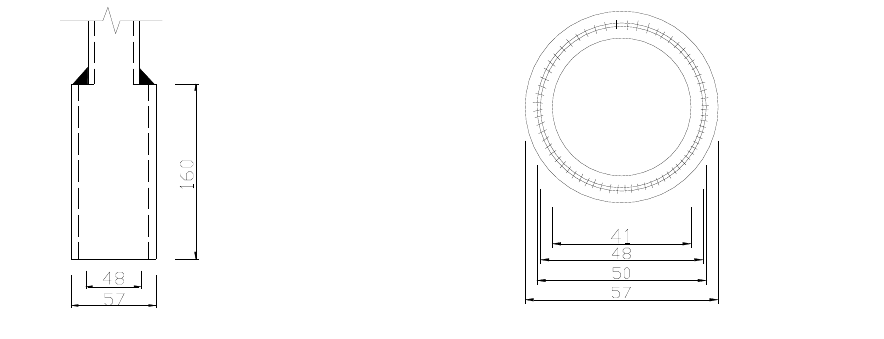
Figure 16. Dimensions of sleeve specimens.